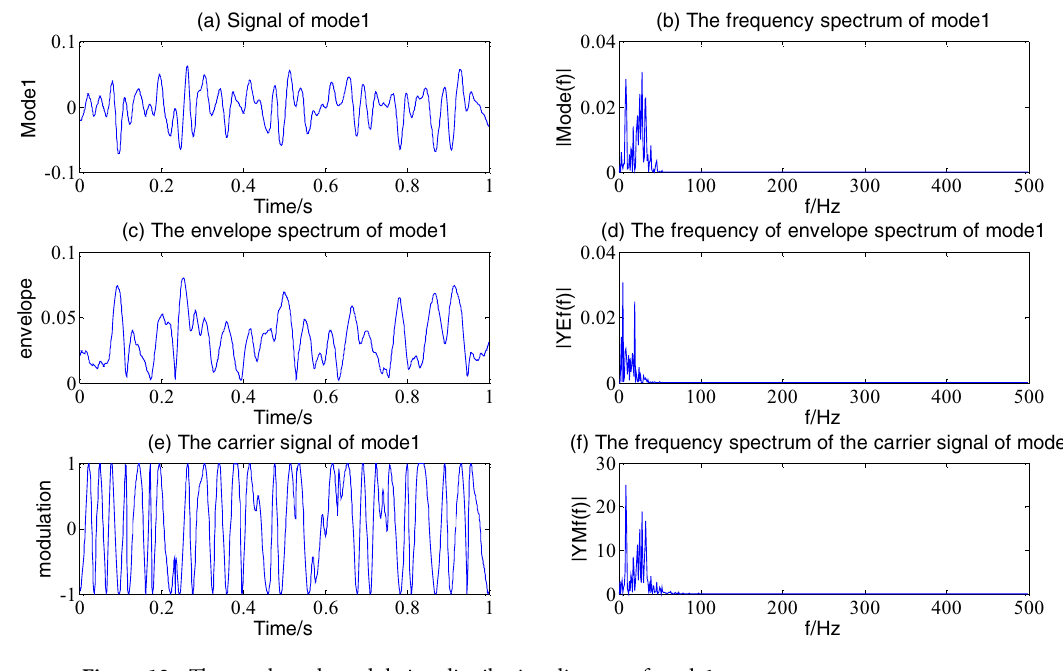
Figure 13. The envelope demodulation distribution diagram of